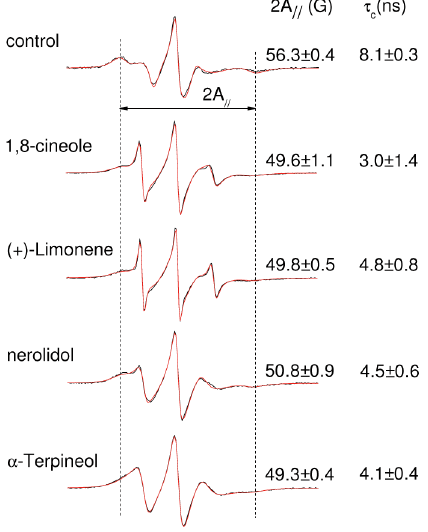
Figure 2. EPR spectra of spin-labeled Leishmania plasma membrane. Experimental (black lines) and best-fit (red lines) EPR spectra of 5-DSA in the plasma membranes of Leishmania amazonensis promastigotes from untreated and terpene-treated samples (4.8 6 10 9 terpenes/cell). The best-fit spectra were obtained with the NLLS fitting, which provided the average rotational correlation time, t c , for each spectrum. Another parameter that is measured directly in the EPR spectrum, 2A // , is indicated by the vertical lines in the figure. The mean and S.D. of t c and 2A // are indicated. For both parameters, all terpene- treated samples were significantly different from the control sample (P , 0.01).